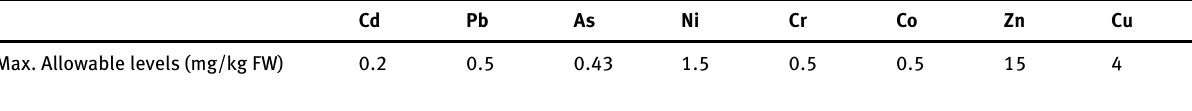
Table 4: Maximum allowable concentrations of measured heavy metals in fresh vegetable tissues